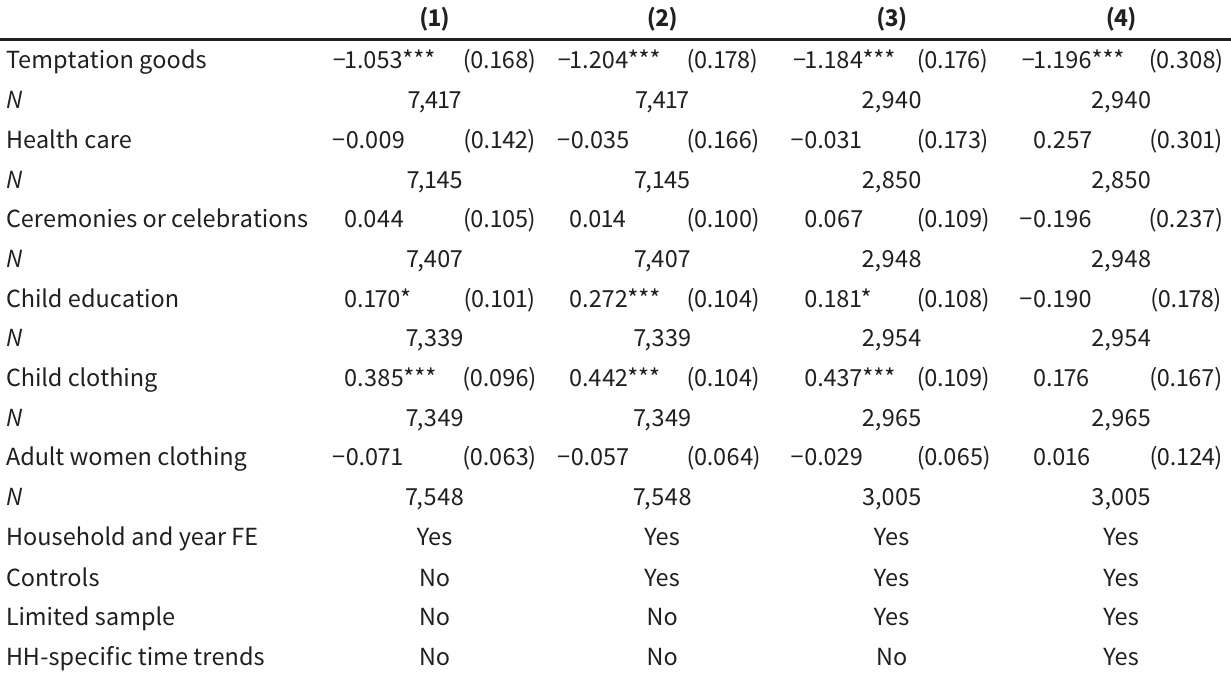
Shifts in expenditures ( asinh ) as the husband’s migrant status changes (1) (2) (3) (4) Temptation